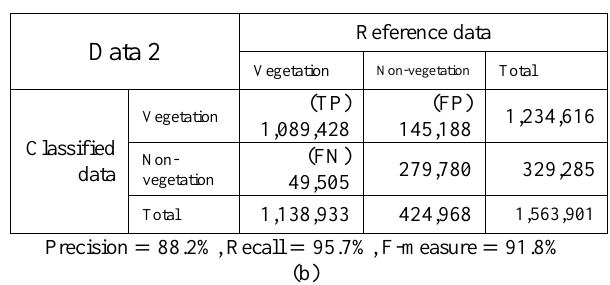
Table 1. Accuracy assessment of (a) Data 1 and (b) Data 2 (Unit: point)